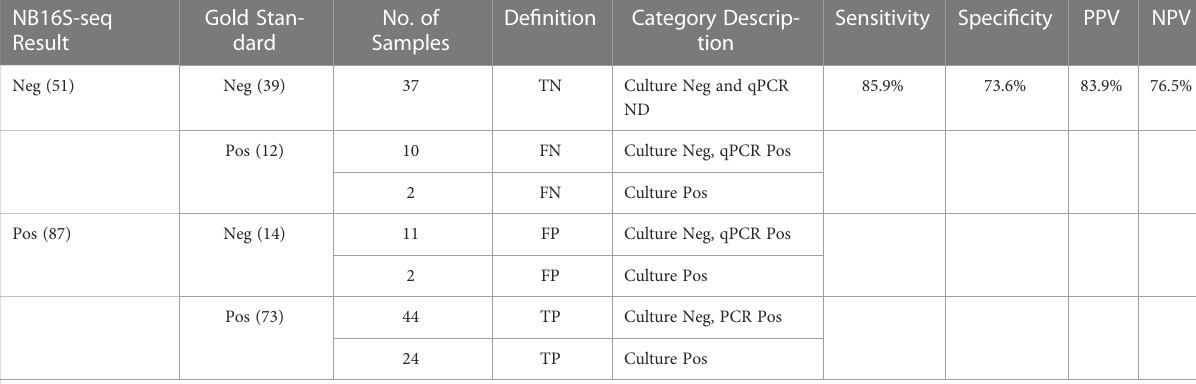
TABLE 4 Evaluating BALF NB16S-seq with the gold standard test (either culture or qPCR).